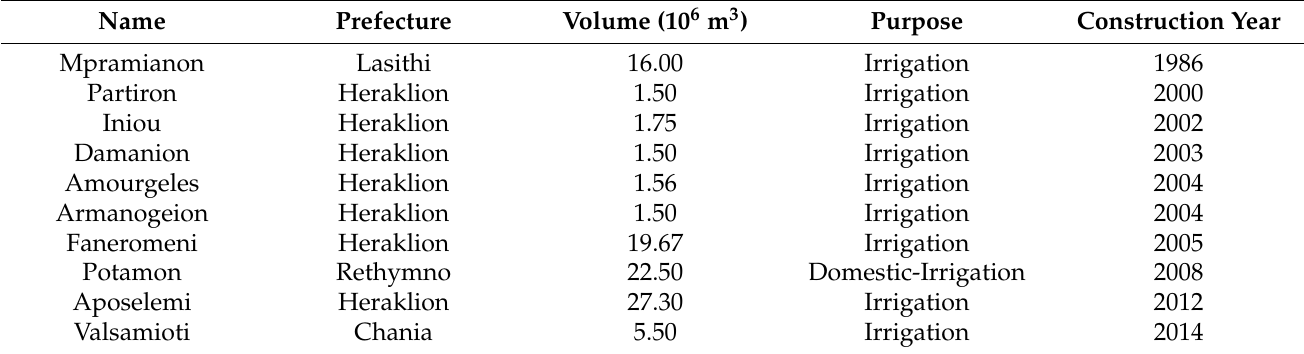
Table 5. Reservoirs on the Crete